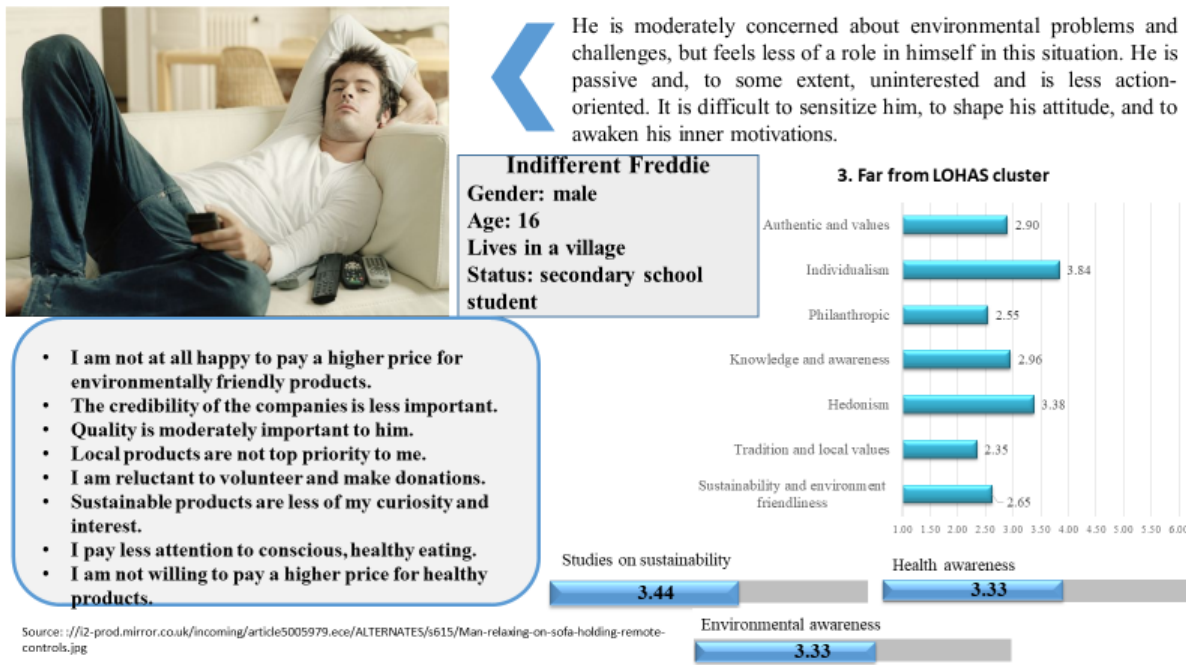
Figure 4. ‘Indifferent’—the persona that is furthest from the LOHAS model. Source: Authors’ own compilation based on the results of cluster analysis, 2022.